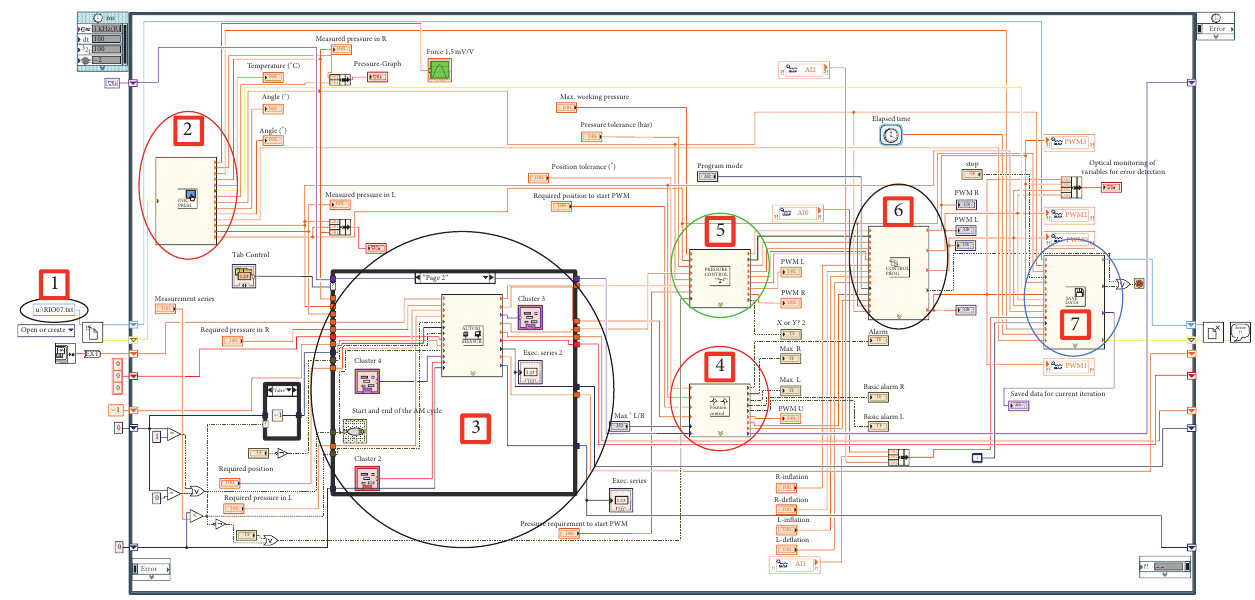
Figure 6: Block diagram of the main